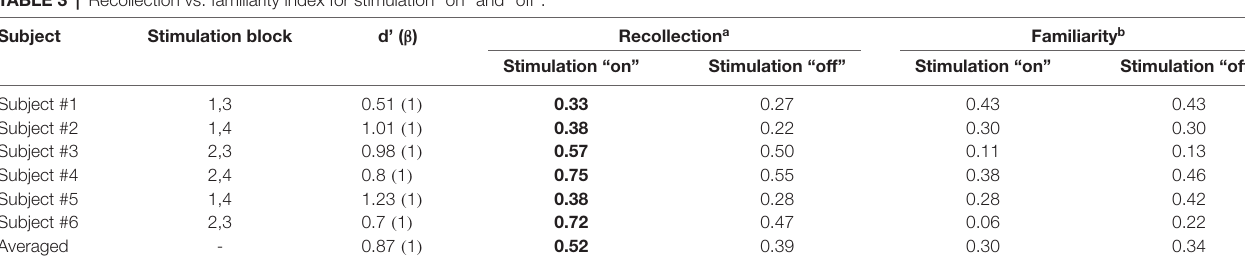
TABLE 3 | Recollection vs. familiarity index for stimulation “on” and